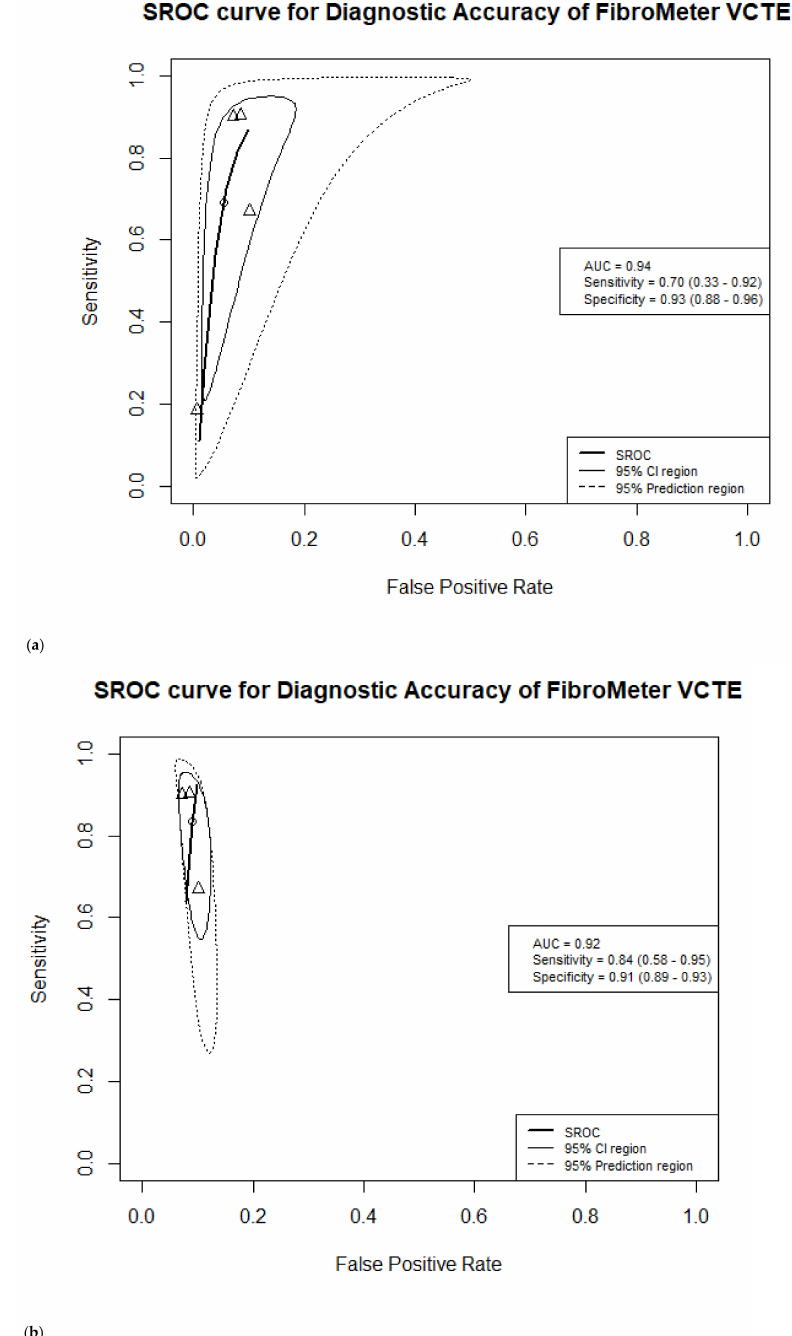
Figure 4. Summary receiver operating characteristic (SROC) curve of the diagnostic accuracy of FibroMeter VCTE for target condition advanced fibrosis. The solid ellipse presents the 95% confi- dence interval region of diagnostic accuracy of FibroMeter VCTE; the dotted ellipse presents the prediction region in which 95% of future diagnostic accuracy study estimates of FibroMeter VCTE will fall. Triangles represent diagnostic accuracy estimates from each included study; circle presents the Youden Index threshold value. ( a ) Before additional sensitivity analyses; ( b ) After additional sensitivity analyses, without study of Loong et al.